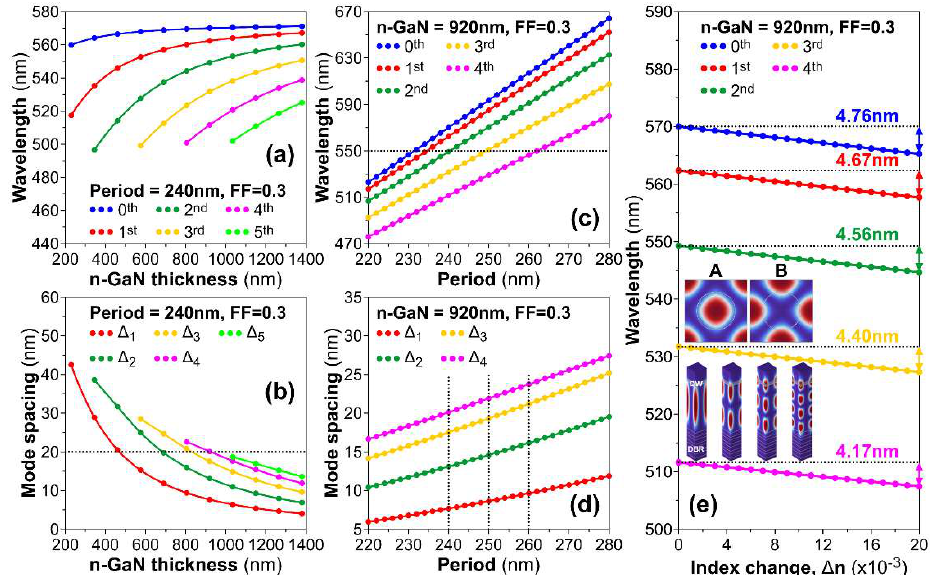
Figure 3. ( a ) FP resonance wavelength as a function of the n-GaN thickness of the µ-PCLED with 5 pairs of QWs. ( b ) Mode spacing of adjacent FP peaks extracted from ( a ). ( c , d ) FP resonance wavelength and corresponding mode spacing as a function of the PC period of the µ-PCLED with 5 pairs of QWs and n-GaN = 920 nm. ( e ) FP resonance wavelength shift as a function of the refractive index change in the µ-PCLED with n-GaN = 920 nm. The PC period and filling factor for the calculation were set to be 240 nm and 0.3. The upper inset shows the top views of two fundamental PC mode profiles labeled by A and B. The vertical-mode profiles of the PC mode A for the 0th-, 1st-, 2nd- and 3rd-order modes are shown in the lower inset.